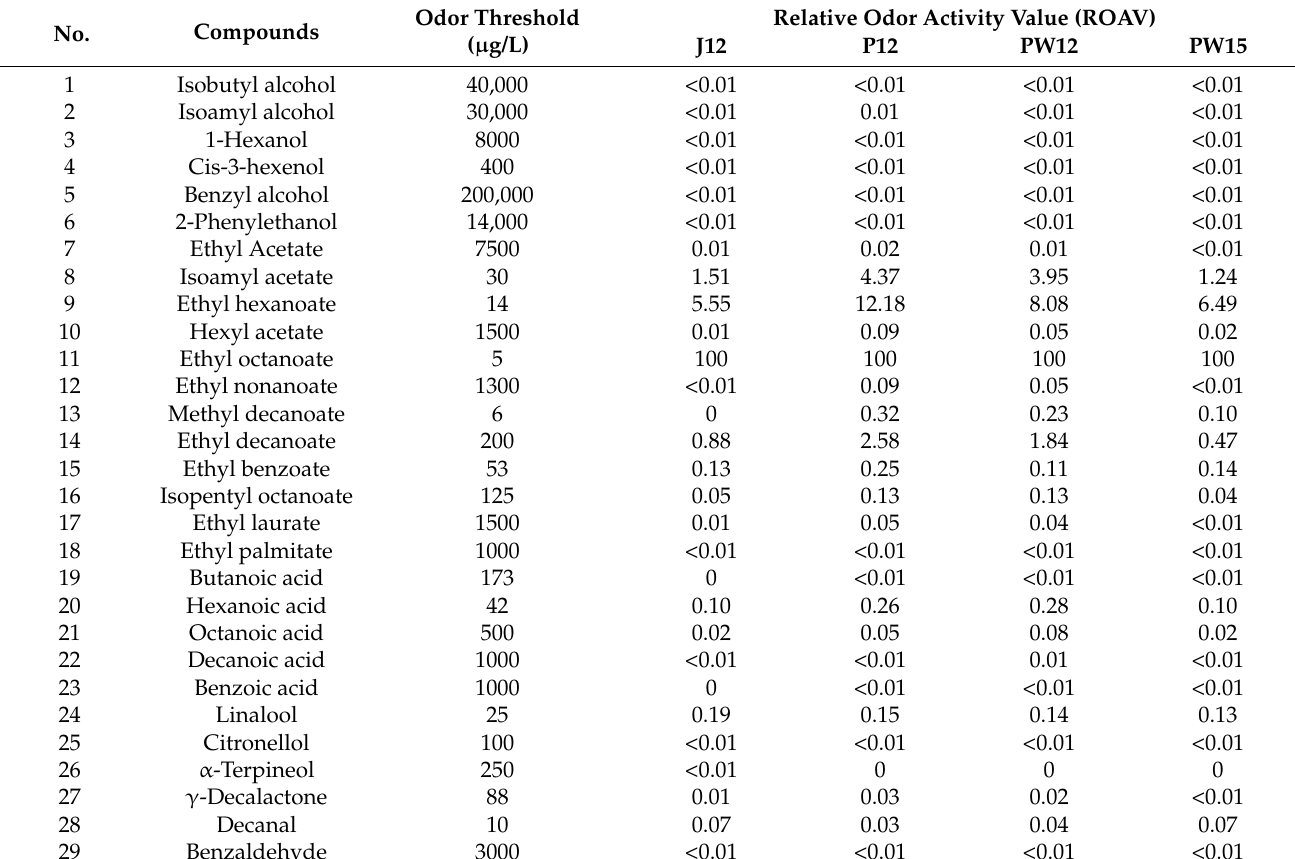
Table 4. Flavor compounds and corresponding ROAV